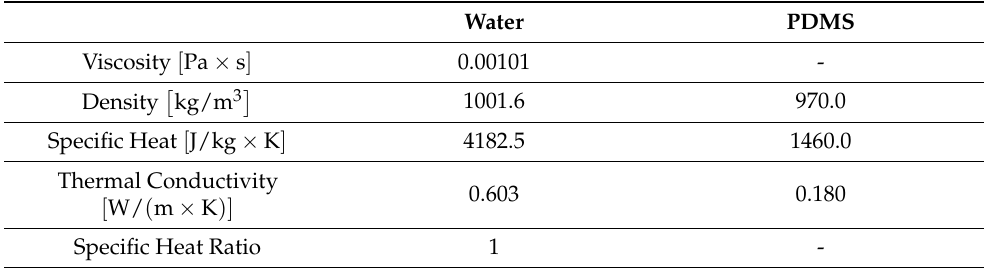
Table 3. Main properties of the fluid and solid used in the numerical simulations. Water PDMS Viscosity [ Pa × s ]